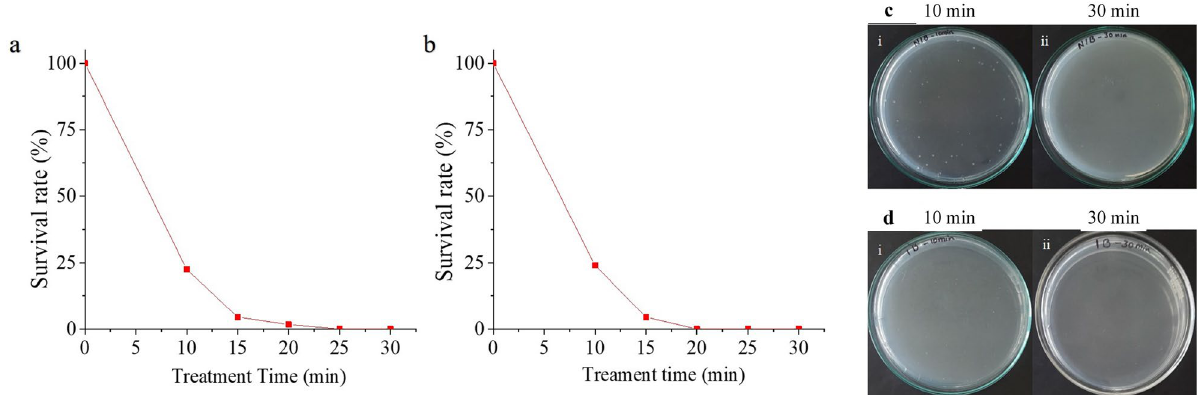
Figure 7. Bubble induced dynamic water treatment-percentage survival rate of E. coli against treatment time for multiple pin HV electrode ( a ) α -configuration and ( b ) β -configuration; E. coli colony in petri dish for different treatment time ( c ) α -configuration and ( d ) β